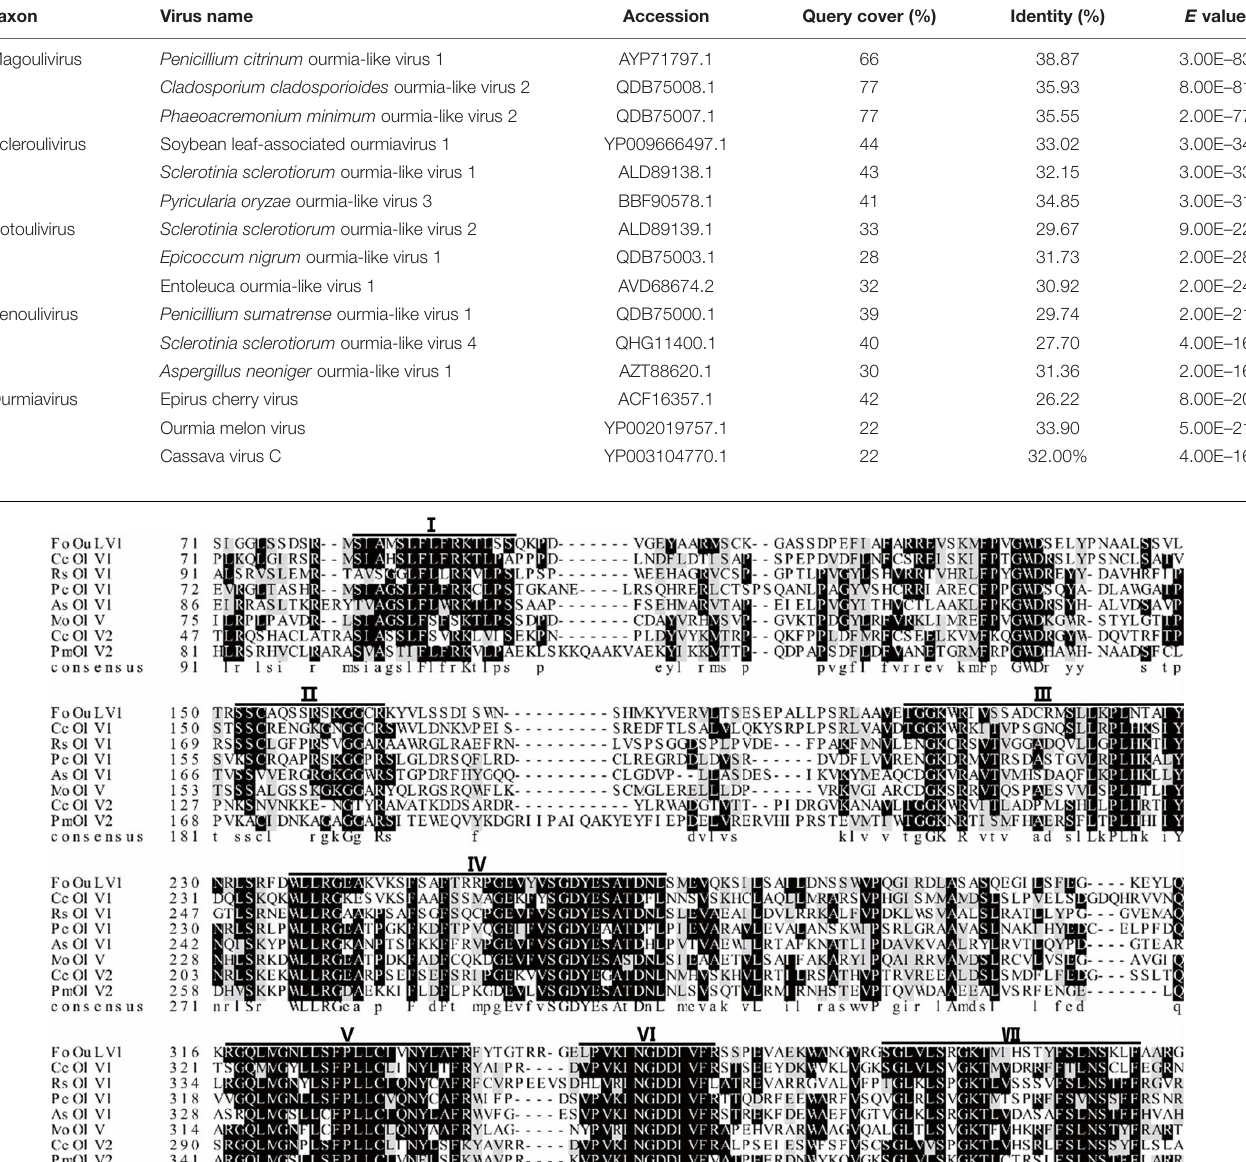
TABLE 1 | Identifications of the RdRp of FoOuLV1 and those of ourmia-like mycoviruses.